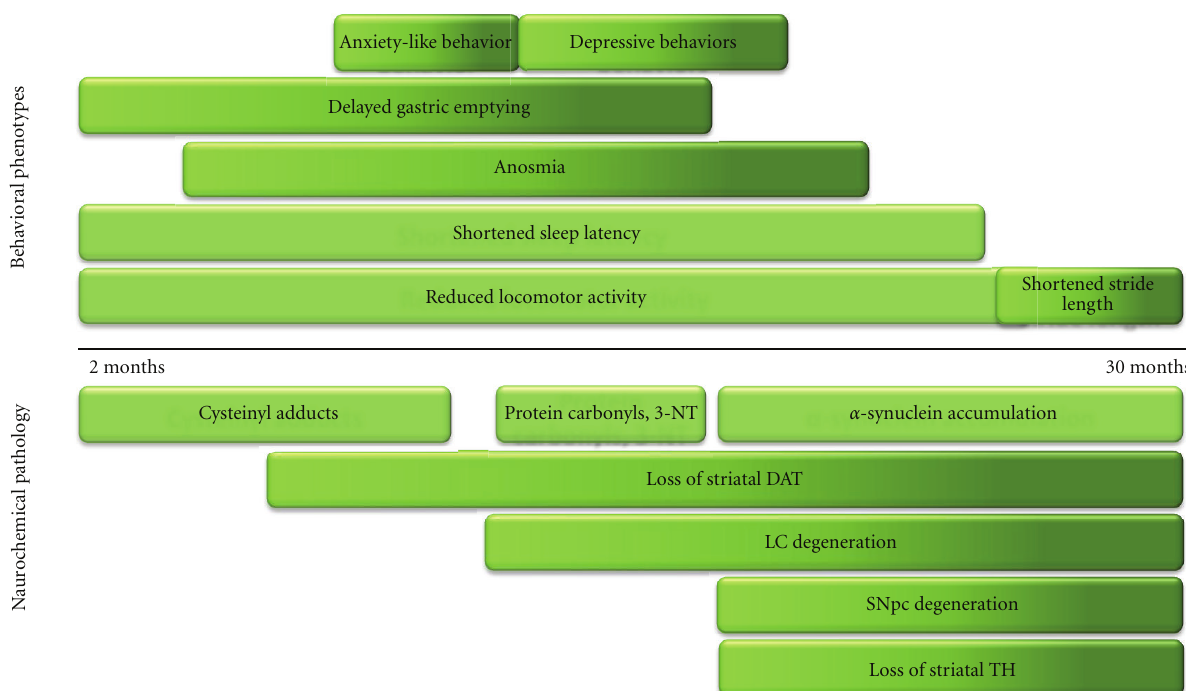
Figure 2: Timeline of Parkinsonian features observed in the VMAT2-deficient mice from 2–30 months of age. Symptoms or pathology indicated by a solid colored box did not increase in severity as the mice aged. All boxes end at the last age the symptom or pathology was measured. Behavioral phenotypes: reductions in locomotor activity and latency to behavioral signs of sleep were first observed at 2 months of age and were found to persist until their last measurements at 6 months of age and 18 months of age, respectively. Gastric emptying was first measured at 2 months of age, and increased in severity until the last time point at 18 months of age. Hyposmia began at 4 months, with full anosmia at 6 months of age and persisting until the last evaluation at 18 months. Anxiety-like behavior was first assessed at 4 months of age, persisting until 6 months of age. Even though depressive-like behaviors were measured at 4–6 months of age, presence of a depressive-like phenotype was not detected until 12 months of age, lasting until 15 months of age. Finally, reductions in forepaw stride length were not seen until 27 months, reaching full severity at 30 months of age. Neurochemical pathology: evidence of oxidative damage was first observed through the formation of cysteinyl adducts at 2 months, which were still present at 12 months. Protein carbonyls and 3-nitrotyrosine formation did not occur until 12 months of age. Accumulation of α -synuclein began at 18 months with evidence remaining until 24 months of age. Loss of striatal DAT expression measured immunohistochemically began at 6 months of age progressing in severity until 22 months of age. Reductions in striatal TH expression begin at 18 months of age, reaching maximal severity at 30 months. Degeneration of the LC starts at 12 months of age in the VMAT2-deficient animals, preceding nigral loss, which does not begin until 18 months of